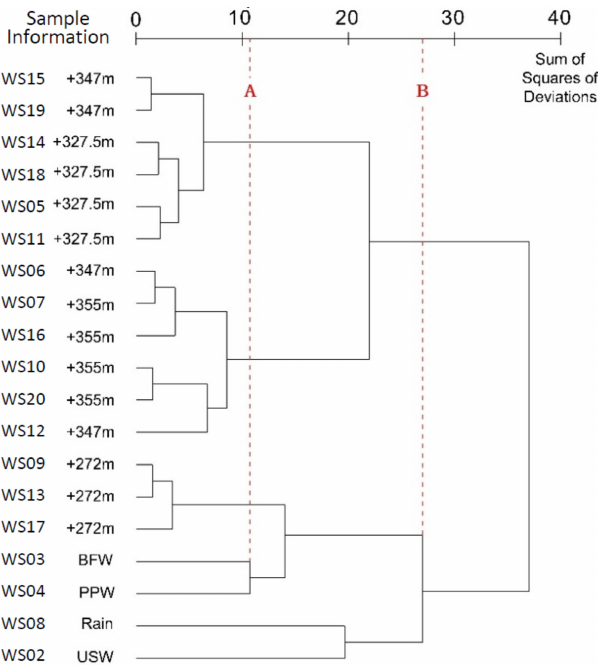
Figure 13. Dendrogram of data through the Ward’s minimum-variance